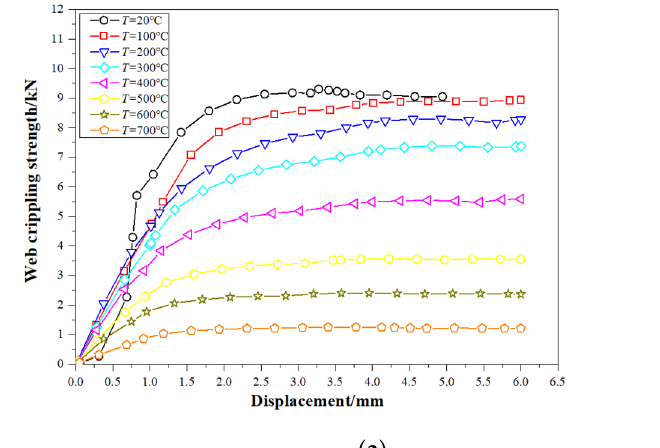
( b ) Figure 7. Web crippling strength reduction factor against a / h for cold-formed steel channel with ( a ) fastened flanges and offset web hole subjected to IOF and ( b ) unfastened flanges and offset web hole subjected to IOF.